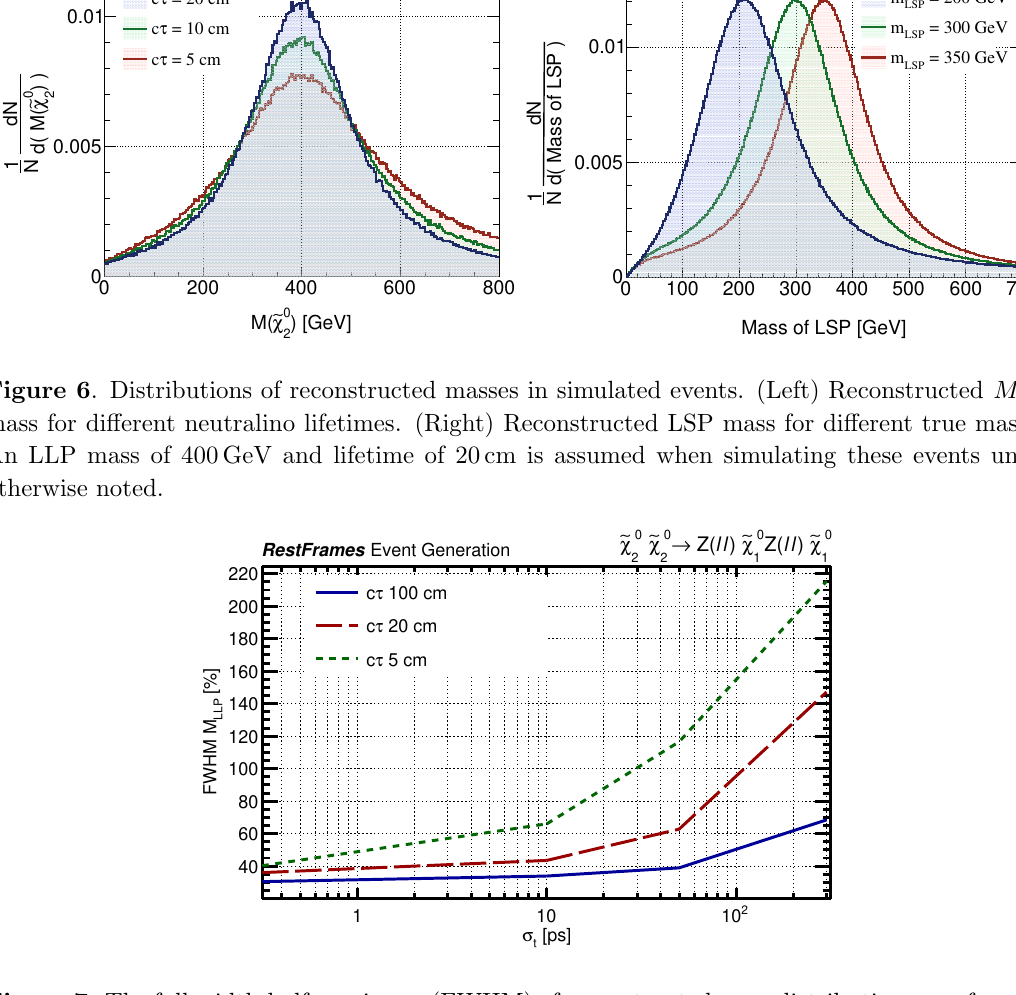
Figure 7 . The full-width-half-maximum (FWHM) of reconstructed mass distributions as a function of timing detector single-track resolution for di(cid:11)erent lifetimes. An LLP mass of 400 GeV and LSP mass of 200 GeV is assumed when simulating these events unless otherwise